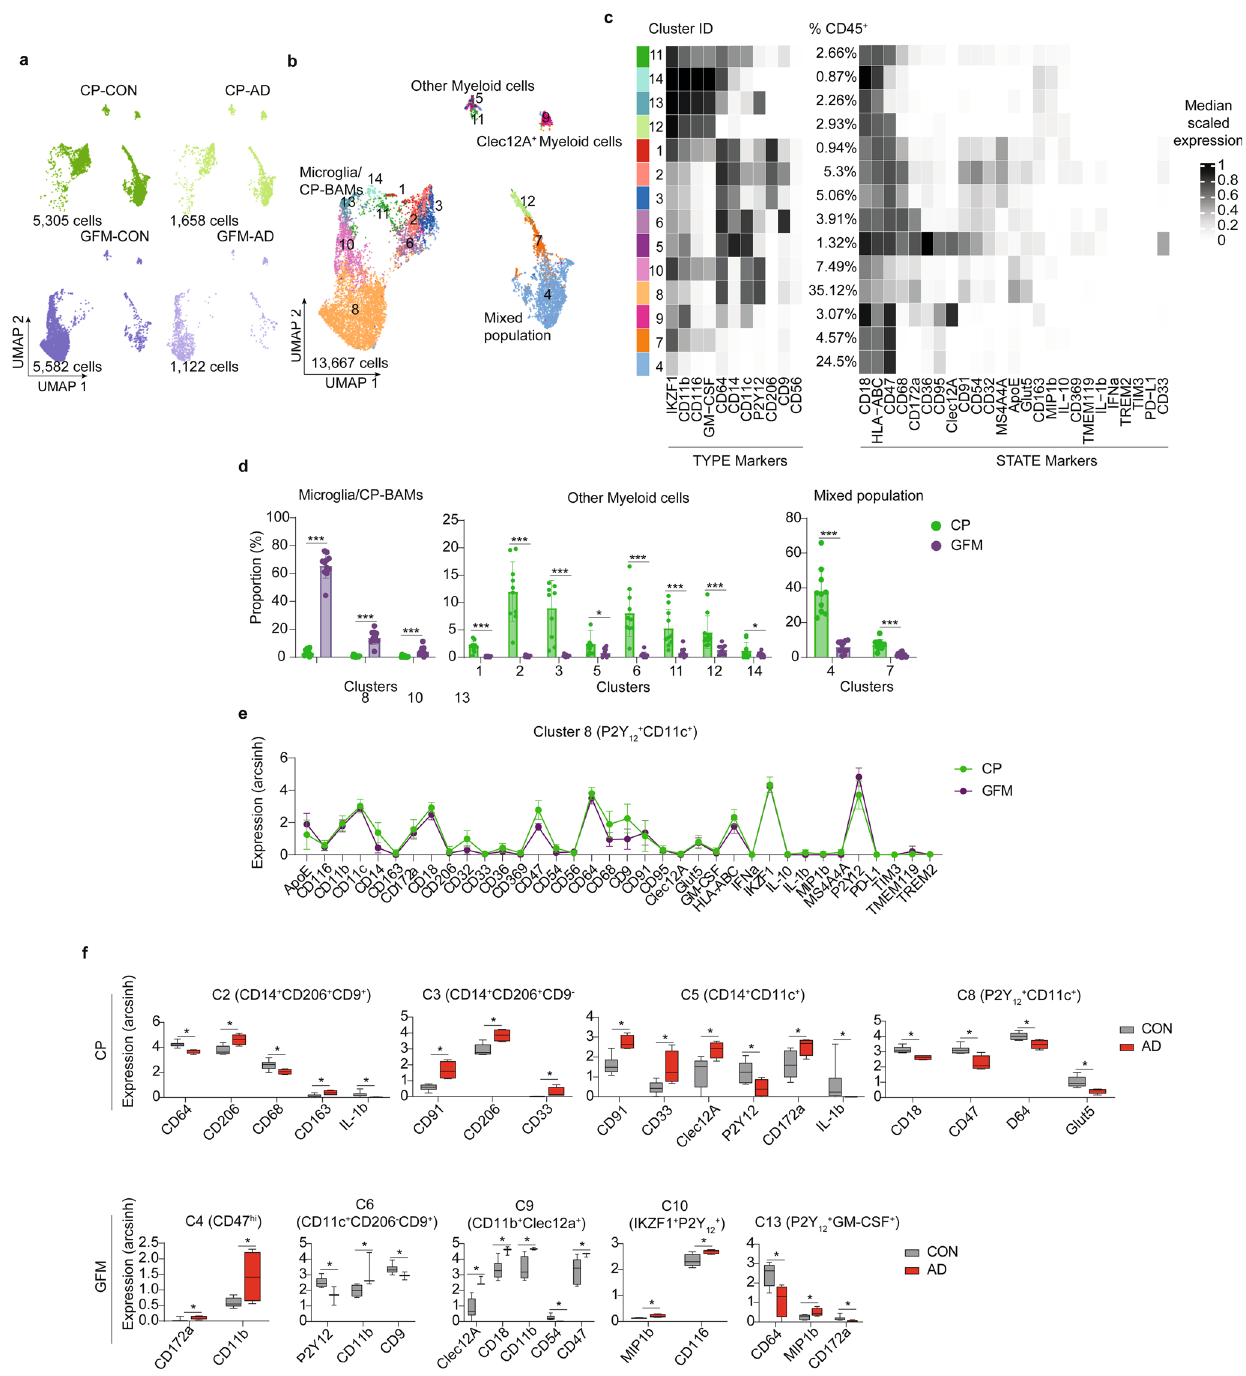
Fig. 8 | Differential heterogeneity of CD45 + immune cells in CP and GFM of AD donors, compared to the CON donors, determined by using Panel B (CP: CON, n =7; AD, n =3, GFM : CON, n =7; AD, n =4, biological replication). a Overlaid UMAP plots of CP and GFM samples from AD (green dots) and CON (purple dots) donors. b UMAP plots of all samples. The colouring indicates 14 clusters repre- senting diverse immune cell phenotypes, de fi ned by the FlowSOM